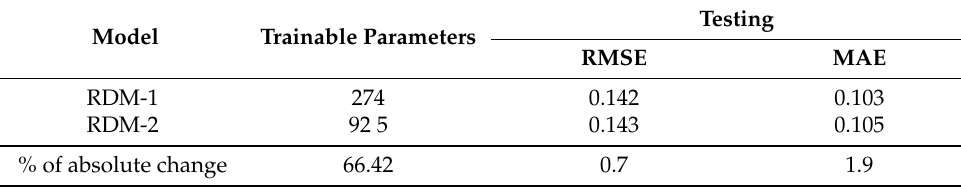
Table 18. Comparison between RNN models for Day Ahead Markets (DAM).